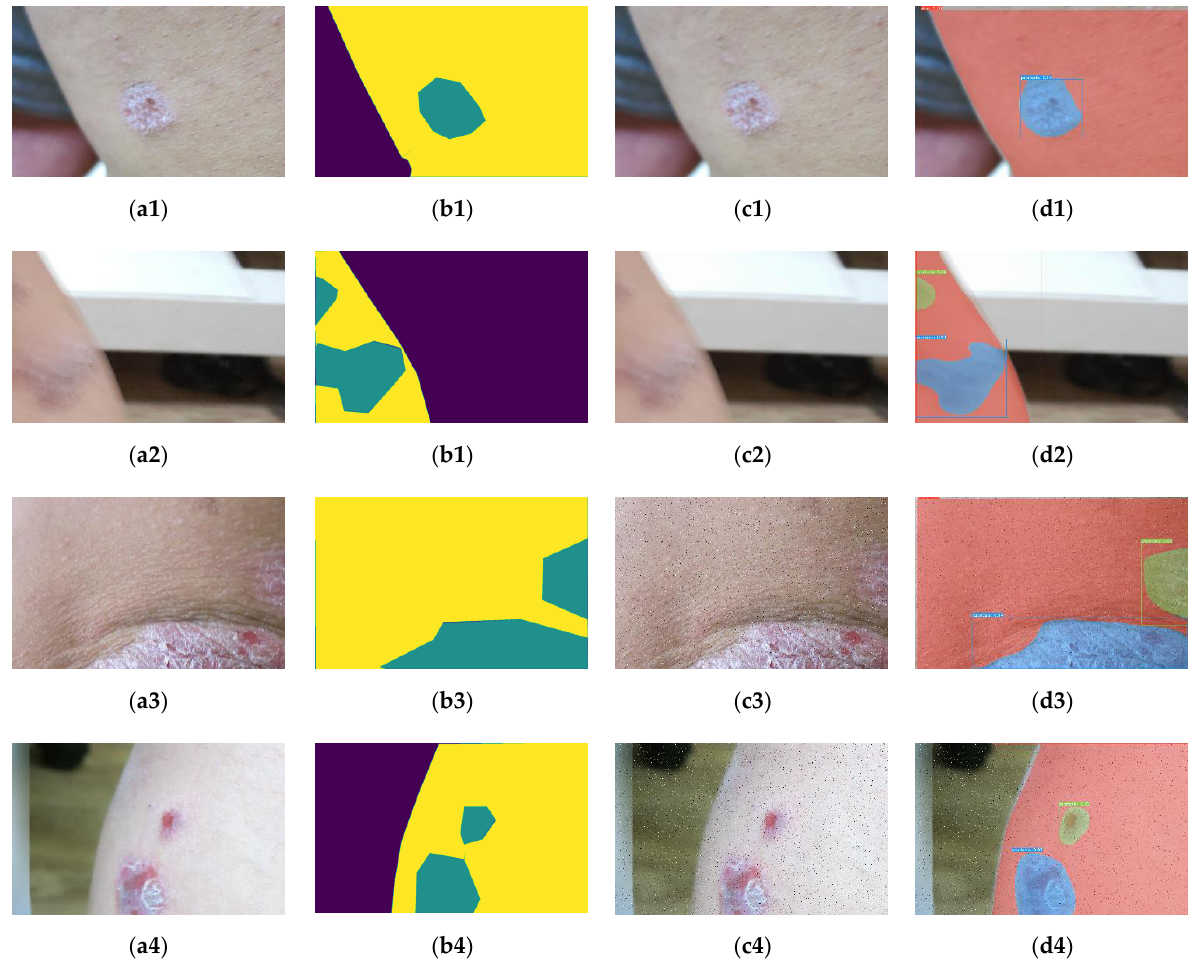
Figure 8. Instance segmentation results: ( a1–a4 ) Input, ( b1–b4 ) ground truth, ( c1–c4 ) blurred/noisy, and ( d1–d4 )